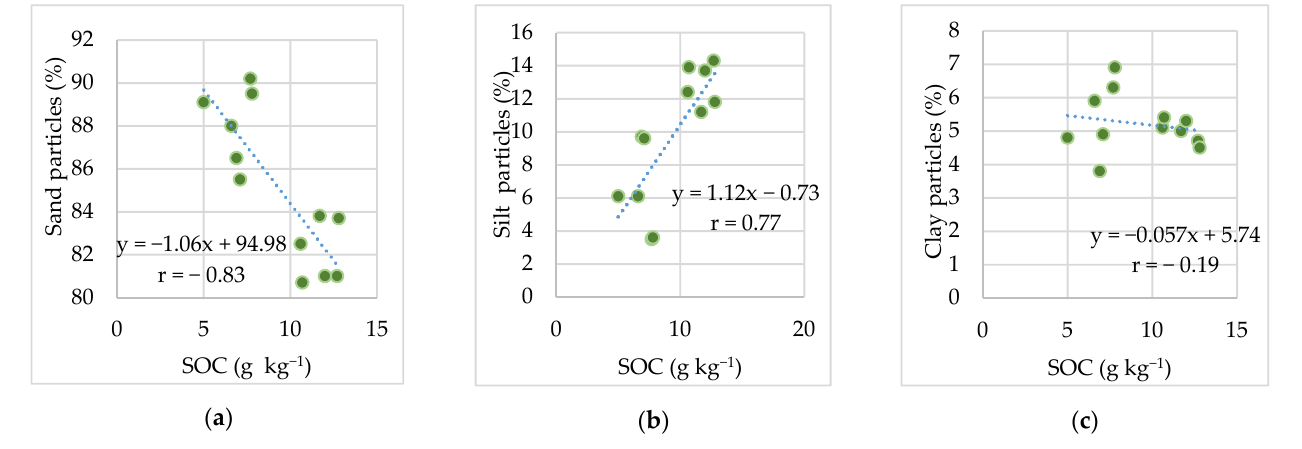
Figure 1. Dependence of organic carbon concentration (g kg − 1 ) on soil particle size. ( a ) sand particle (2000–63 µm); ( b ) silt particle (63–2 µm); ( c ) clay particle (<0.002 mm).